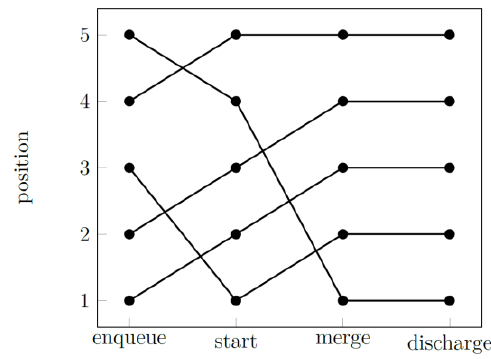
Figure 5. Ordered sequences of the fifth cyclist in the queue Q(5,2) violating the FIFO principle (marked by points where the lines cross each